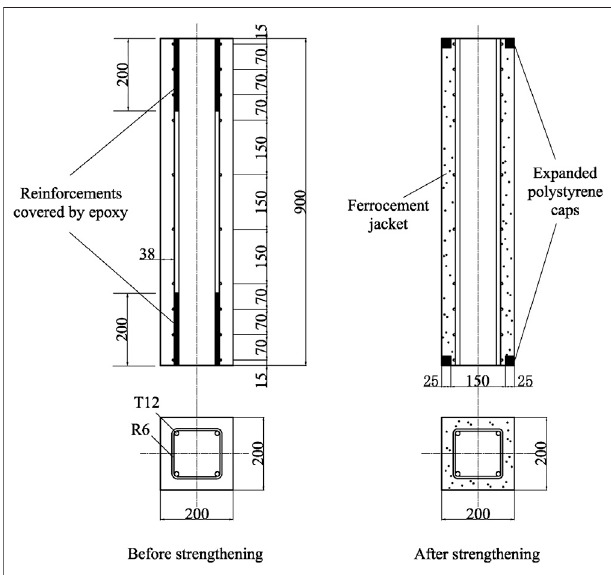
FIGURE 2 | Schematic view of column specimen (unit: mm).